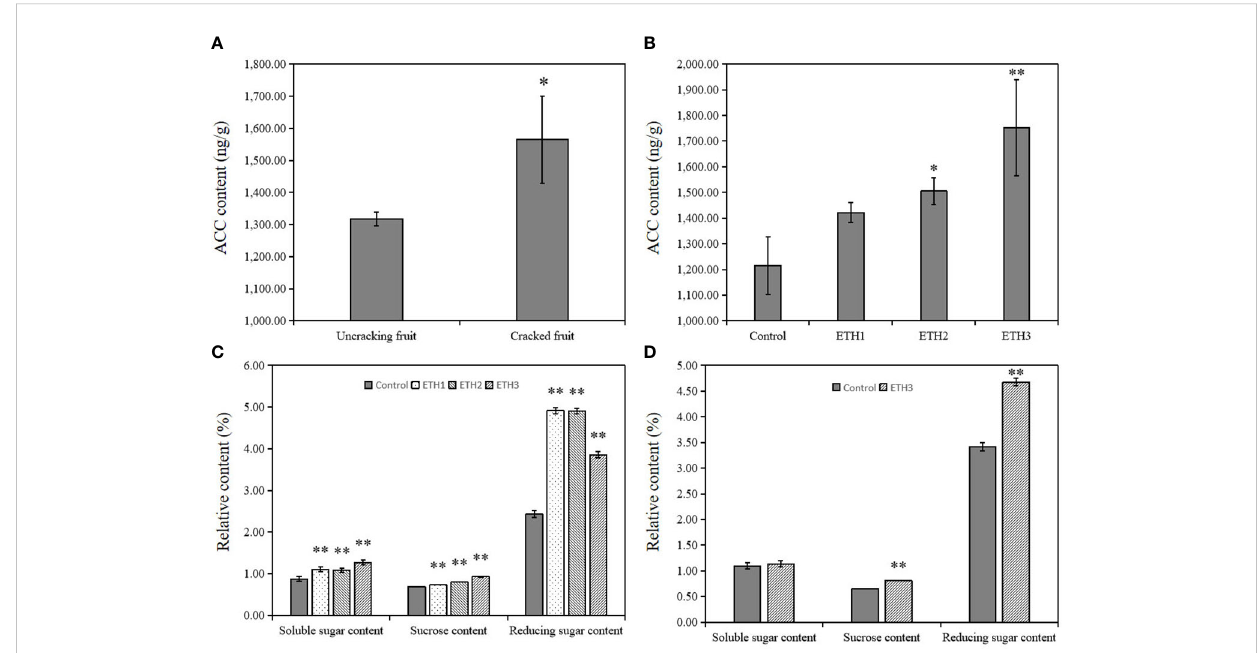
FIGURE 1 Contents of ACC and sugar in C.oleifera ‘ Huashuo ’ seeds harvested in Liuyang. (A) ACC contents in seeds of uncracking and cracking fruits; (B) ACC contents of seeds with different treatments (ETH1, ETH2, ETH3), and the control in 2020; (C) Sucrose, soluble sugar, and reducing sugar contents of seeds with different treatments (ETH1, ETH2, and ETH3), and the control in 2020; (D) Sucrose, soluble sugar, and reducing sugar contents of seeds with ETH3 treatment and the control in 2021. ETH1, ETH2, and ETH3 represent 0.5, 1.0, and 1.5 g L -1 ethephon, respectively. Single and double asterisks indicate differences at P < 0.05 and P < 0.01, respectively.